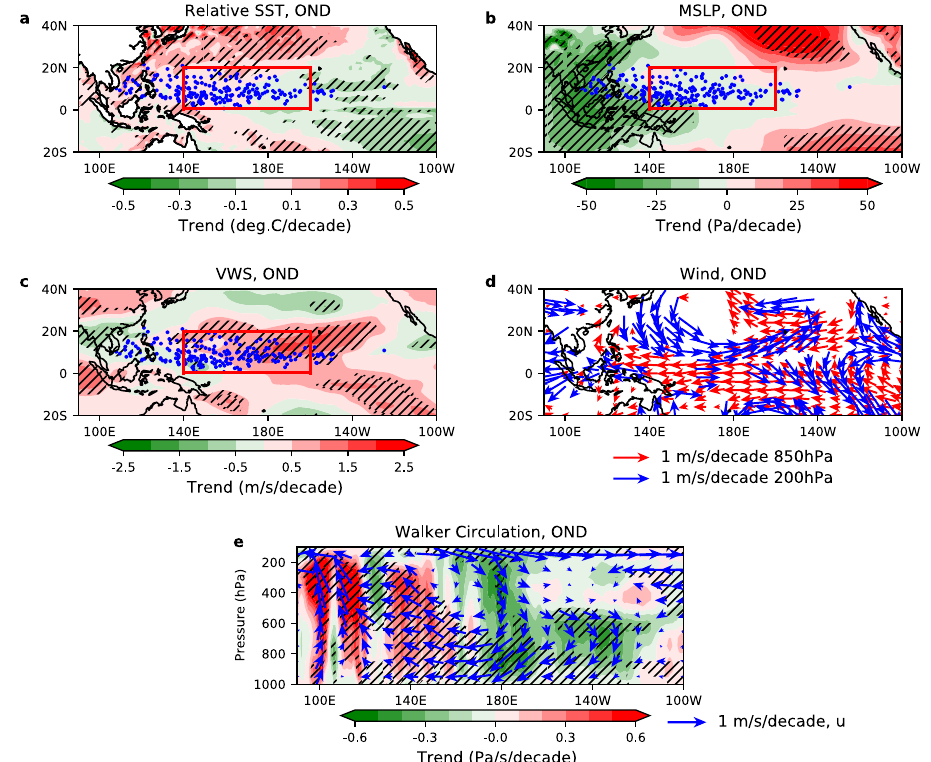
Fig. 5 Changes in late-season environmental conditions in the Paci fi c. a – d Linear trends (shading) of relative sea surface temperatures (relative SSTs), mean sea level pressure (MSLP), vertical wind shear (VWS) and wind velocity at 850 and 200 hPa (vectors), for the late season (October – December; OND), over 1979 – 2018, in ERA-Interim. Relative SSTs are SSTs minus the average of global SSTs in 30°S – 30°N. Blue dots present late-season TC genesis in the ERA-Interim TC dataset; red box (140°E – 160°W and 0 – 20°N) represents the main development region (MDR) of late-season TCs. e Linear trends of the late-season Walker Circulation (vectors) and vertical velocity (shading; positive values for uplifting) in the zonal-vertical section averaged over 5°S – 5°N, over 1979 – 2018, in ERA-Interim. Hatched areas in a – c , e and vectors in d show 95% con fi dence for the linear fi t; the El Niño Southern Oscillation and Paci fi c Decadal Oscillation effects are removed by a multivariate regression; in e , trends of vertical velocity are multiplied by 10 2 for